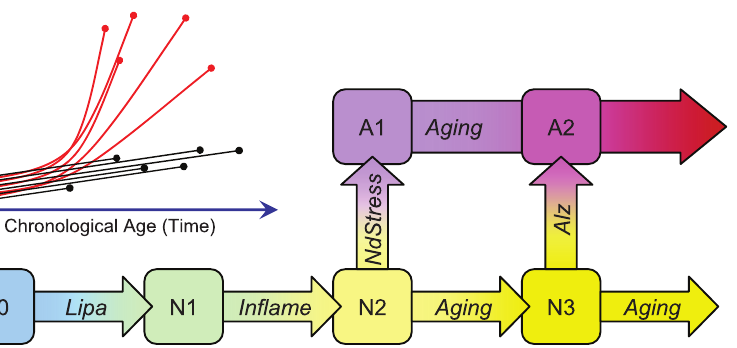
Figure 7. Disease progression model. The trajectories of BioAge changes as a function of time reflect the relatively constant rate of aging in non- demented subjects (black), and acceleration of the rate of aging in AD (red). The dots represent the postmortem state of the brain captured by gene expression profiling. The state transition model defines several broad categories for normal brains N0–N3 and for diseased states A1 and A2. The sequence of transitions and associated gene expression biomarkers are shown by